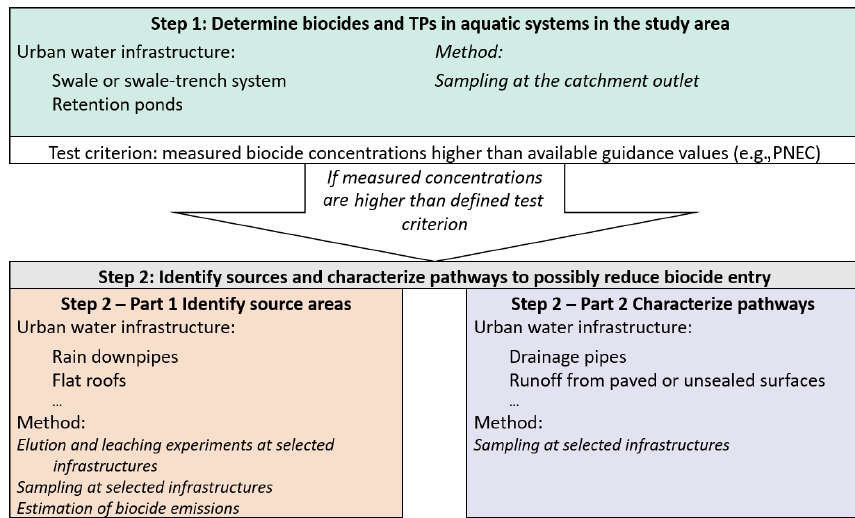
Figure 1. A two-step approach focusing on urban water infrastructure.